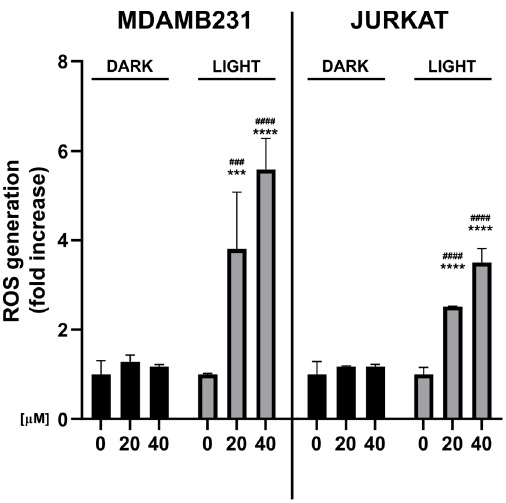
Figure 7. ROS generation in Jurkat and MDA-MB-231 cells after treatment with doxorubicin 20 or 40 µM for 2.5 h followed or not by light irradiation for 30 min. Results are expressed as mean ± SD. *** p < 0.001; **** p < 0.0001 vs. untreated cells; ### p < 0.001; #### p < 0.0001 vs. the same concentration of doxorubicin in dark conditions.